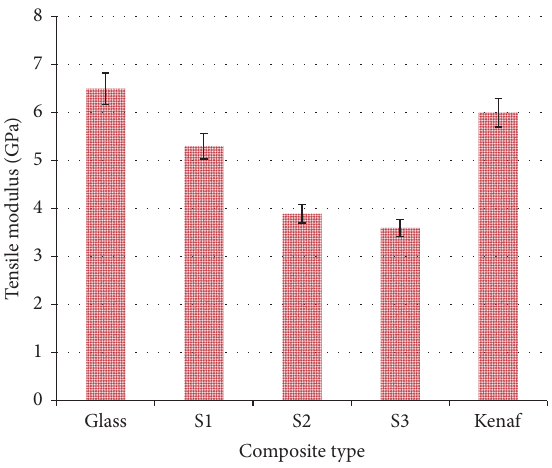
Figure 3: Tensile modulus of composites.